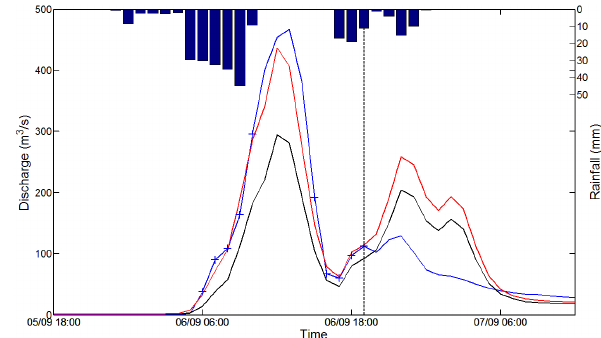
Fig. 7. Data assimilation results for the September 2005 event. The blue curve corresponds to observations; the black curve is the background simulated hydrograph (before assimilation), and the red curve is the analysis simulated hydrograph (after assimilation). Blue crosses represent the assimilated data points.